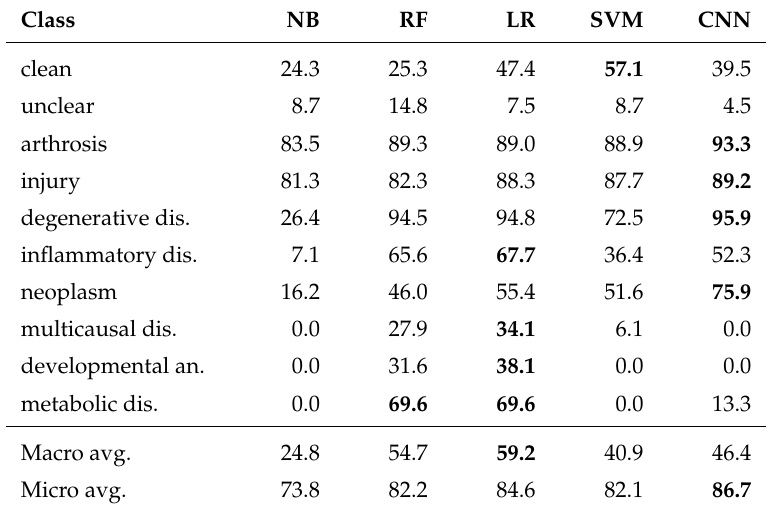
Table 4. Results (in terms of F 1 scores) for all five text classification models used on each of the 10 knee condition labels. The last two rows show the micro- and macro-averaged F 1 performance over all 10 classes. The results presented here were obtained via nested 10-fold